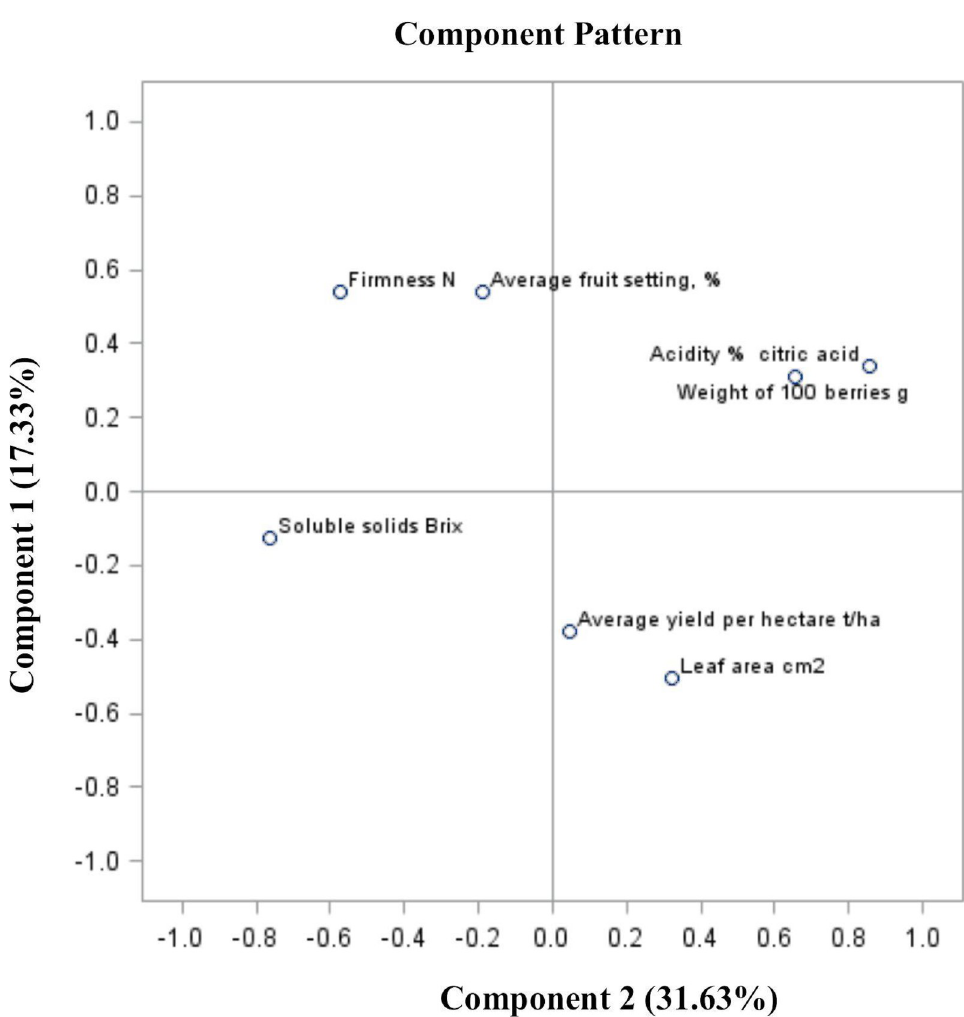
Fig 3. PCA analysis of blueberry fruit in terms of yield size and quality parameters in